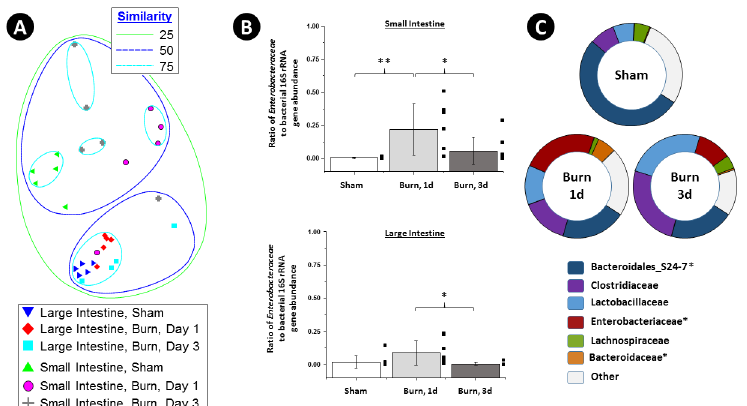
Fig 2. Burn Injury Alters the Mouse Intestinal Microbiome. The non-metric multidimensional scaling (NMDS) plot ( A ) demonstrates the differences in microbial community structure as a result of burn injury, time since burn injury, and sampling from small and large intestine in a mouse experimental model system of five animals per group. Box-plots of the distribution of the ratio of rRNA genes from Enterobacteriaceae to total bacterial rRNA genes in sham and burn animals, calculated by qPCR, are shown for small and large intestines, one and three days post-burn injury (B) . A statistically significant effect of burn injury was observed between sham and one-day burn injury mice in the small intestine (n = 9 sham, 7 burn mice, two-tailed t-test ** , p < 0.01), and between one-day and three-day burn injury mice (n = 9 sham, 8 burn mice, two-tailed t-test * , p < 0.05). A statistically significant effect of burn injury was observed for the large intestine between one- day and three-day burn injury mice (n = 8 animals per group, two-tailed t-test * , p < 0.05). The most abundant bacterial families in sham and burn injury mice (small intestine) are indicated in pie charts (C) , and taxa which were significantly different by Kruskal-Wallis one-way analysis of variance ( * , FDR-P <